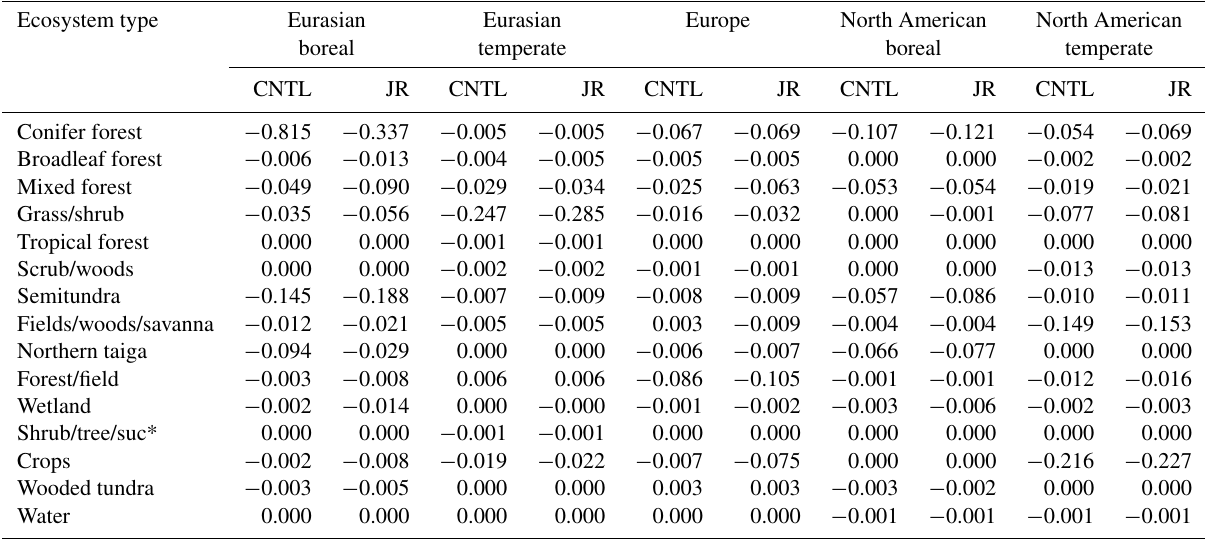
Figure 5 is the same as Fig. 4 but covers land regions in